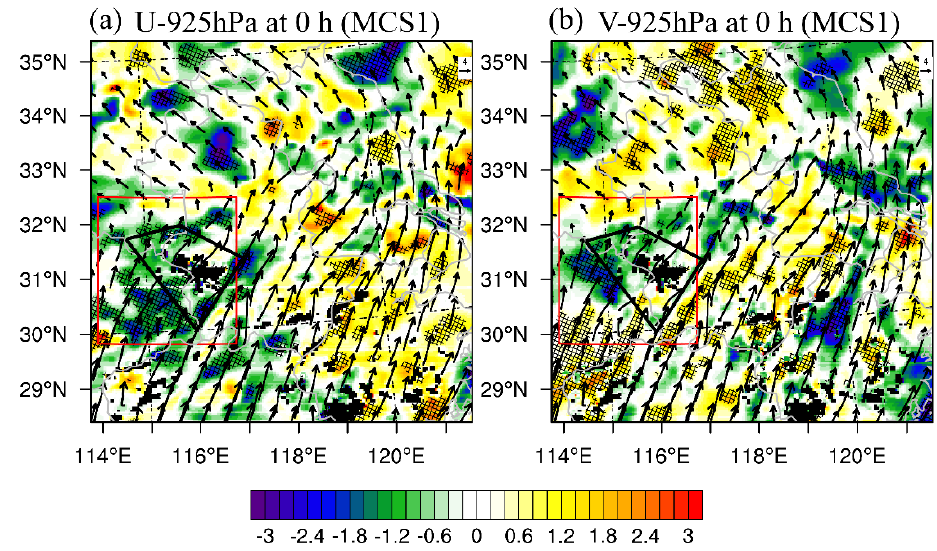
Figure 10. Sensitivity of hourly precipitation in the MCS1 region (red rectangle) at 14:00 UTC 6 July (2 h) to ( a ) 925-hPa zonal wind (shaded, mm (m s −1 ) −1 and ( b ) 925-hPa meridional wind (shaded, mm (m s −1 ) −1 ) at 12:00 UTC (0 h). Black shading indicates regions where the sensitivity is statistically significant at the 95% confidence level. The black vectors are 925-hPa ensemble mean wind fields. The black polygon outlines the general range of the Dabie Mountains.